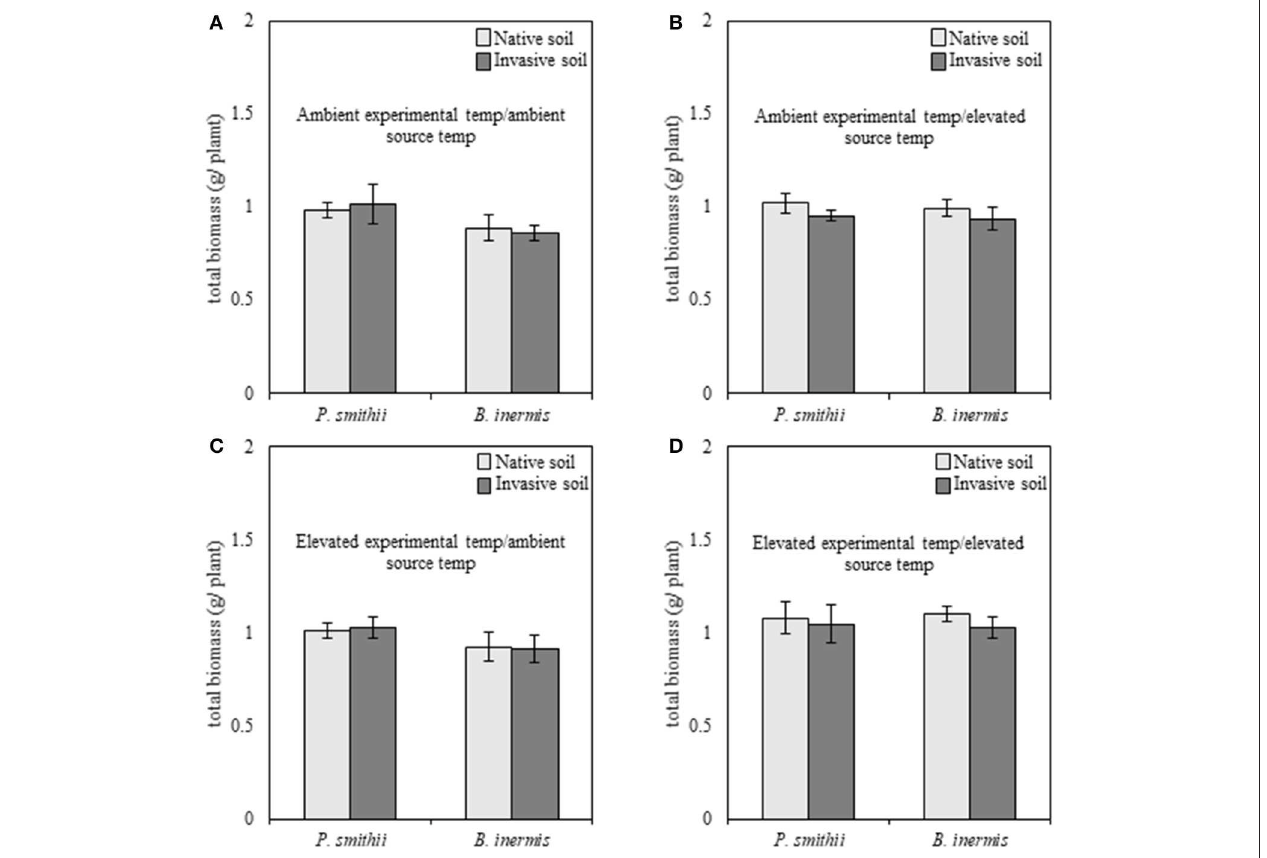
FIGURE 3 | Total biomass production of native ( Pascopyrum smithii ) and invasive ( Bromus inermis ) cool-season grasses grown under well-watered conditions in response to source soil plant identity and source soil temperature. Light bars indicate inoculum derived from native Pascopyrum smithii and dark gray bars represent inoculum derived from invasive Bromus inermis . In each panel, pairings of bars on the left represent native P. smithii , and bars on the right represent invasive B. inermis . Panels represent the following treatment combinations: (A) ambient experimental temperatures, ambient source temperatures, (B) ambient experimental temperatures, elevated source temperatures, (C) elevated experimental temperatures, ambient source temperatures, and (D) elevated experimental temperatures, elevated source